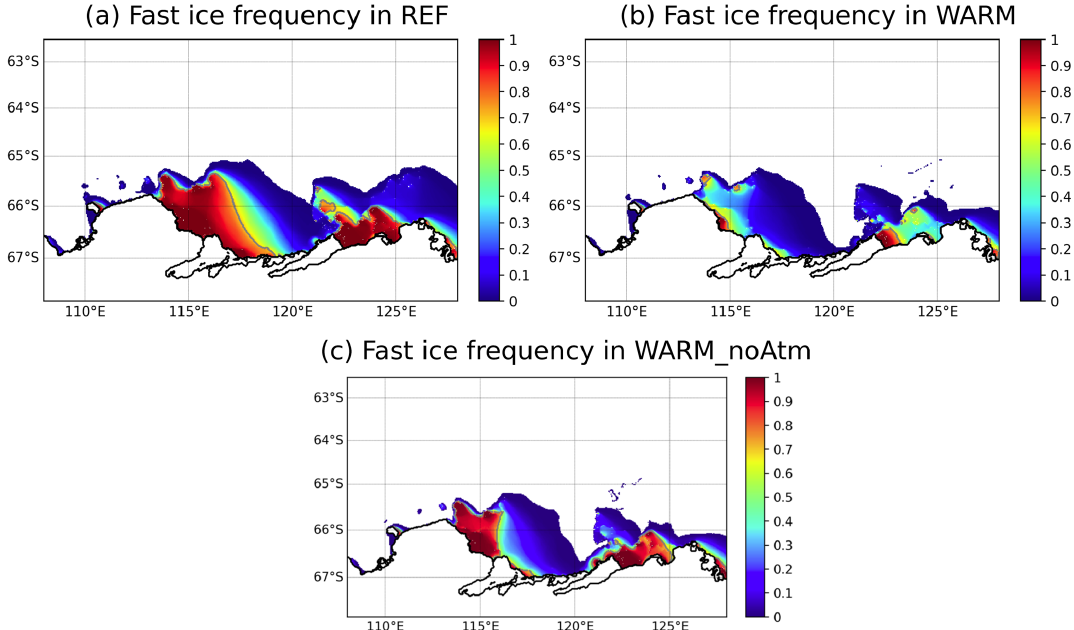
Figure 4. Fast ice frequency for the REF (a) , WARM (b) and WARM_noAtm (c) simulations, all averaged over the 20 years of simulation. The 0.75 fast ice frequency is shown by the gray line.